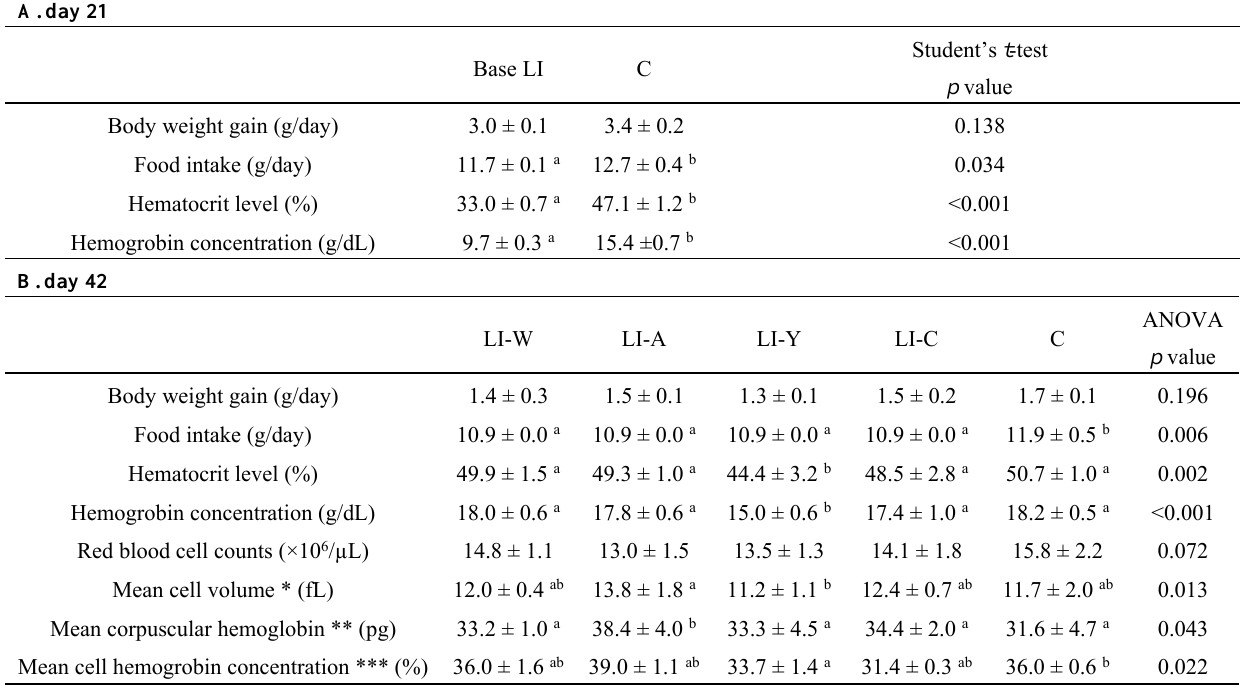
Table 2. Body weight gain, food intake and blood parameters on the day 21 and day 42 after the start of